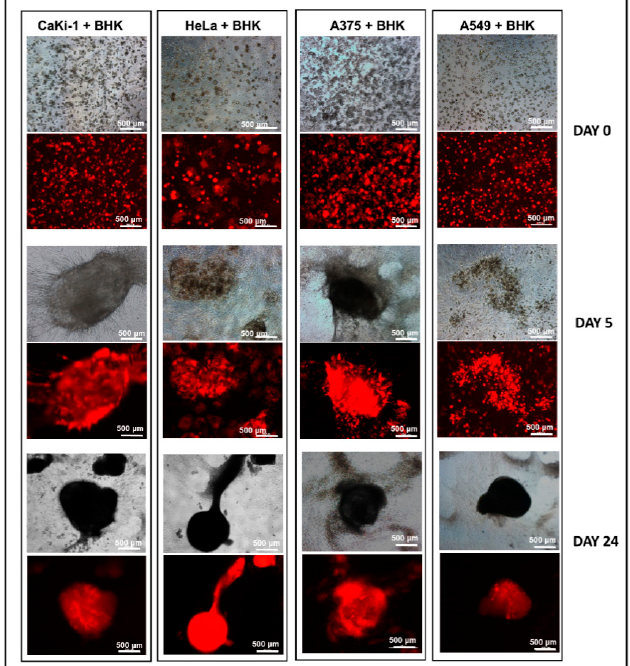
Figure 5. Encapsulation of cancer cells by fibroblast spheroids in 3D Matrigel. CaKi-1, HeLa, A375 and A549 were co-cultured with BHK-21 in 50% Matrigel for a period of up to 30 days. As shown by the fluorescent microscope images, almost the entire cancer cell population was encapsulated within the spheroids by the end of day